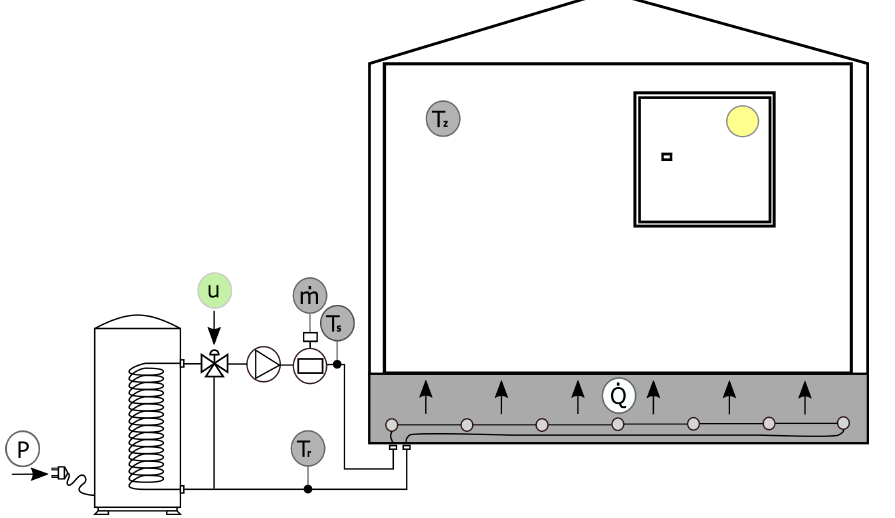
Figure 2. Scheme of the Vliet test